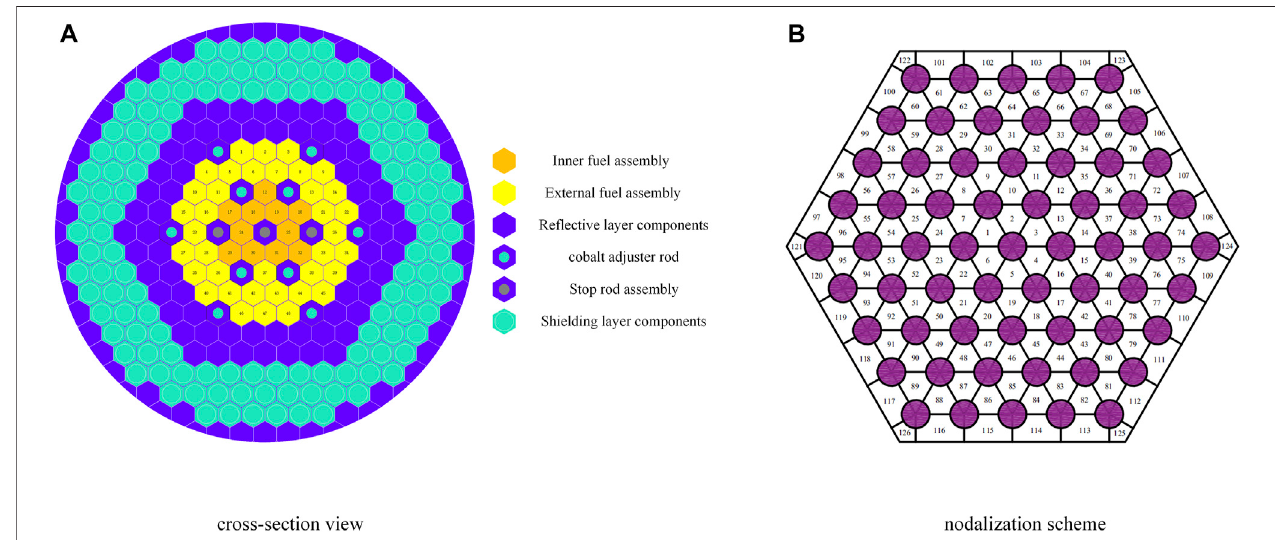
FIGURE 4 | Cross-section view and the nodalizaiton scheme of SPALLER-100 core.